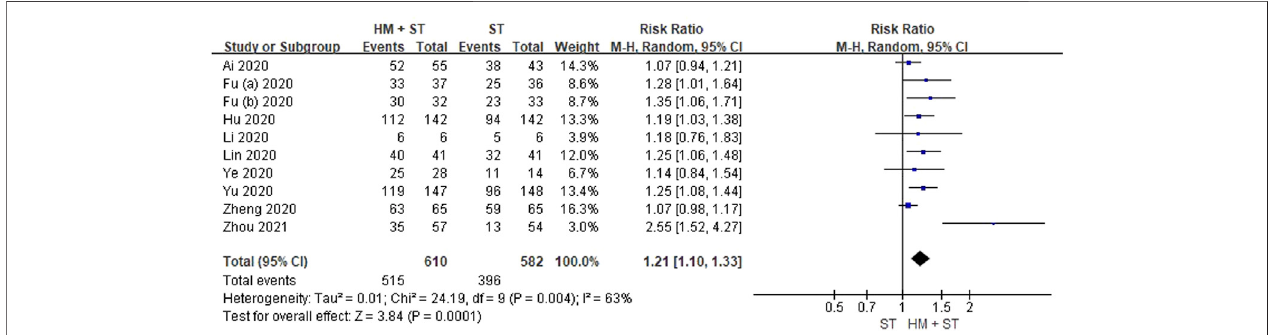
FIGURE 2 | Forest plot for total effective rate of herbal medicine treatment in COVID-19